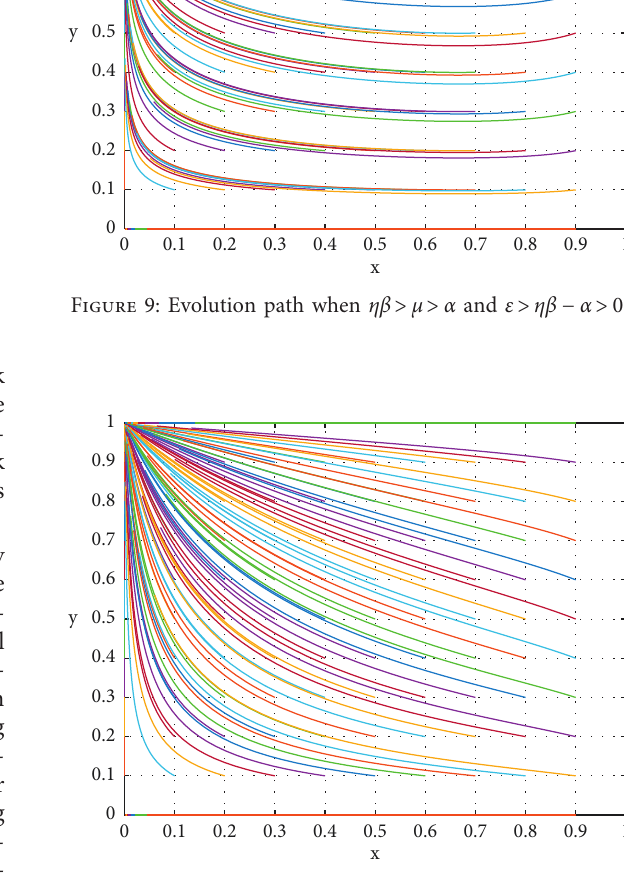
Figure 10: Evolution path when ηβ > α > μ and ε > ηβ − α > 0.